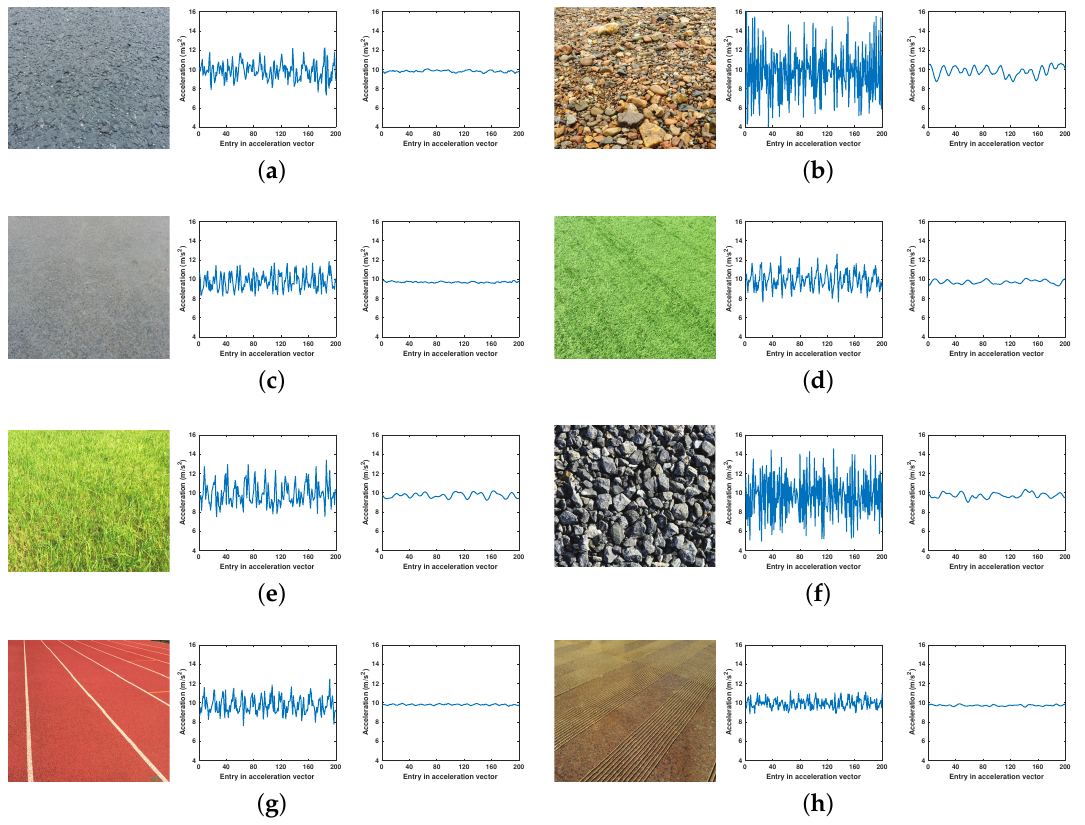
Figure 1. Examples of eight terrain types along with corresponding samples of undampened vibration signals ( left ) and dampened vibration signals ( right ). ( a ) Asphalt. ( b ) Cobble. ( c ) Concrete. ( d ) Grass 1 (artificial grassland). ( e ) Grass 2 (natural grassland). ( f ) Gravel. ( g ) Plastic. ( h )